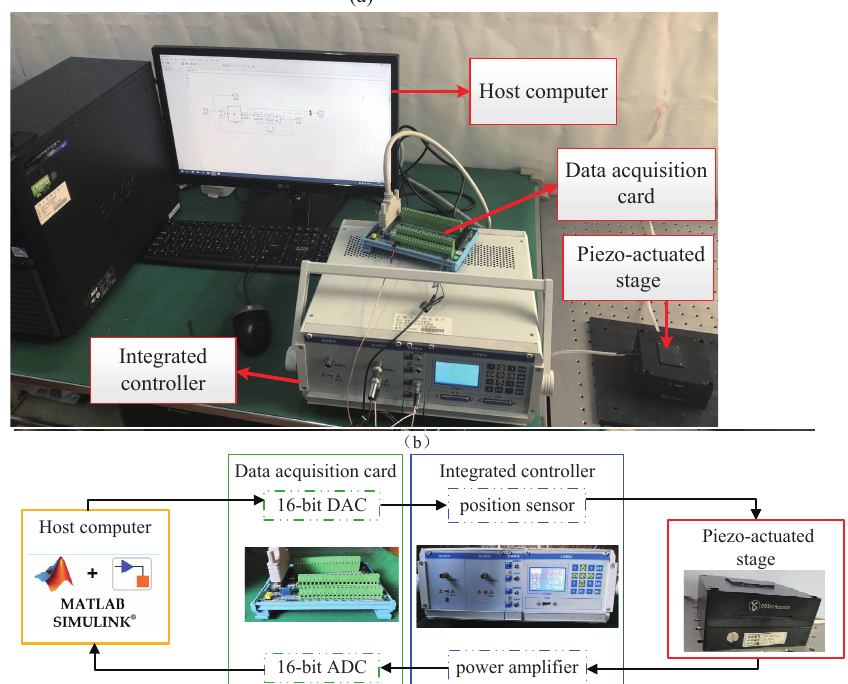
Figure 3. ( a ) Picture of the experimental testbed. ( b ) Schematic of the experimental